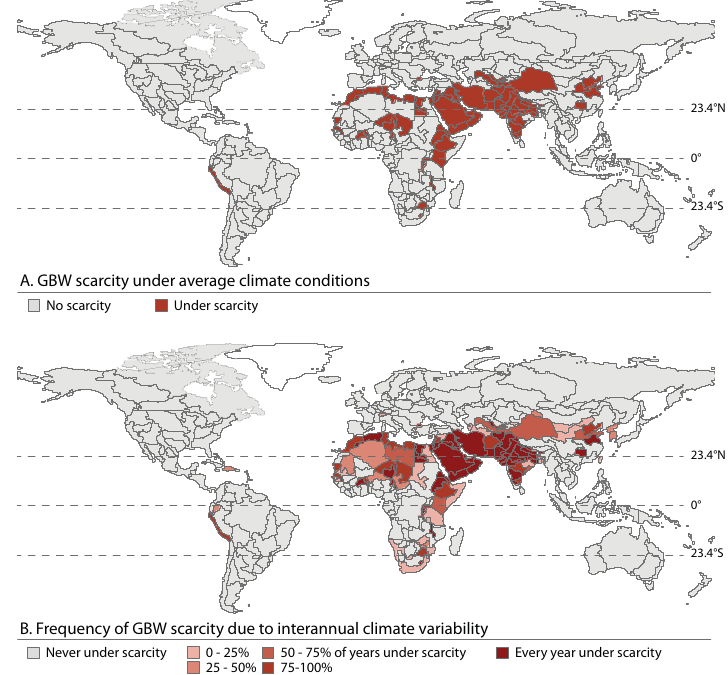
Fig. 2. Green-blue water (GBW) scarcity mapped by FPUs. (A) GBW scarcity under average climate conditions over 30yr climatic period; and (B) frequency of GBW scarcity due to interannual climate variability. The marked latitudes represent the Tropic of Cancer (23.4 ◦ N), Equator (0 ◦ ), and Tropic of Capricorn (23.4 ◦ S). Note that the calculations were made for constant reference population and agronomical practices (year 2000 situation) but varying climate over the period of 1977–2006, in order to isolate the impact of climate variability on GBW